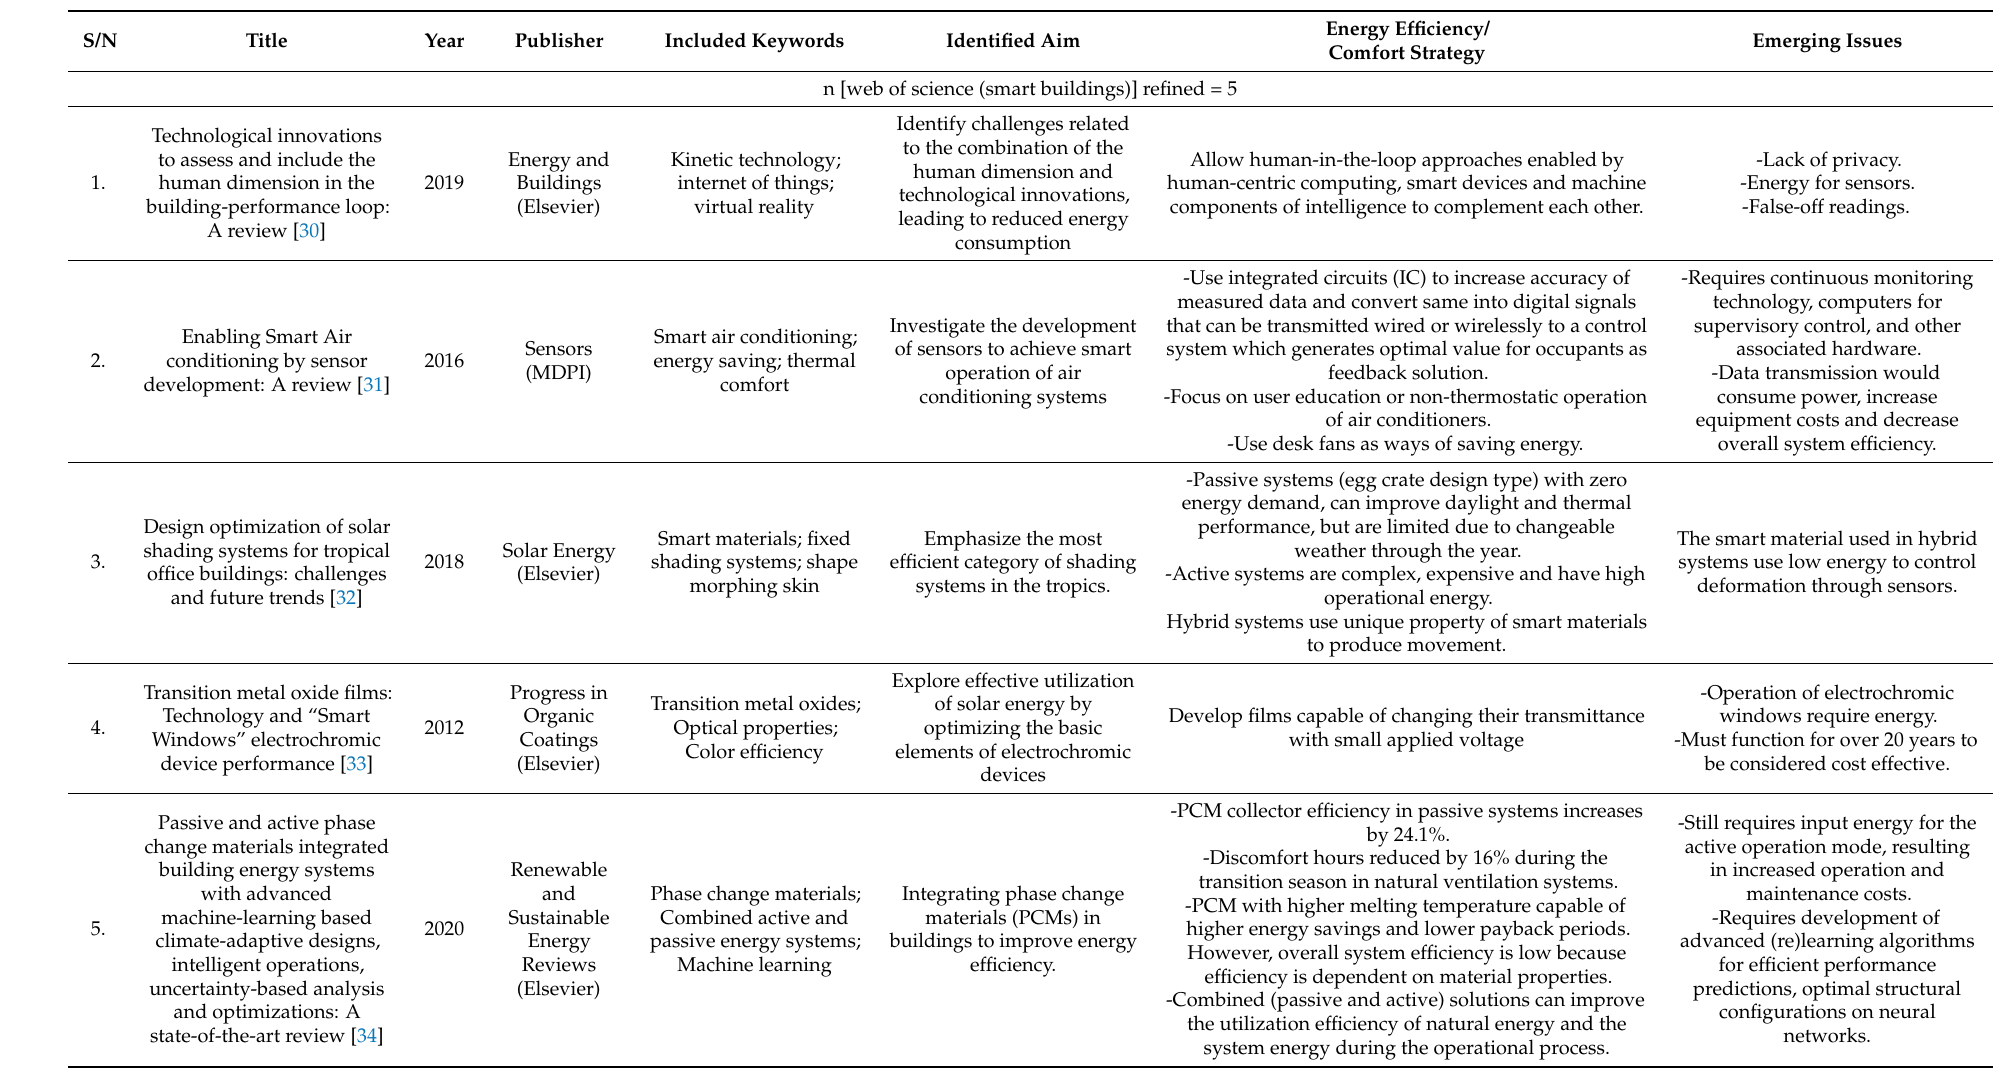
Table 2. Concise summary of articles from Web of Science and Scilit